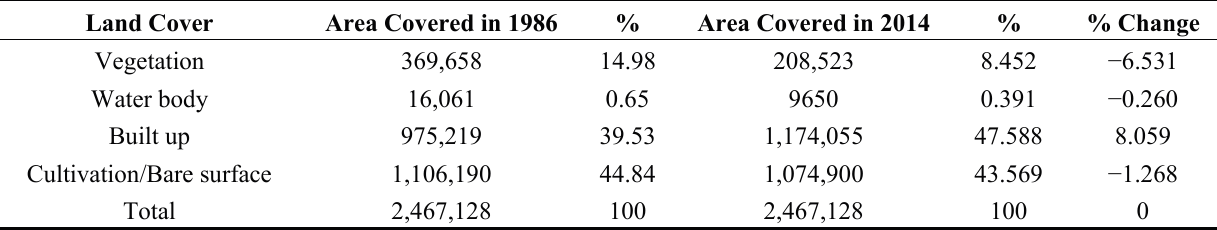
Table 3. Landcover change in Barakinladi.